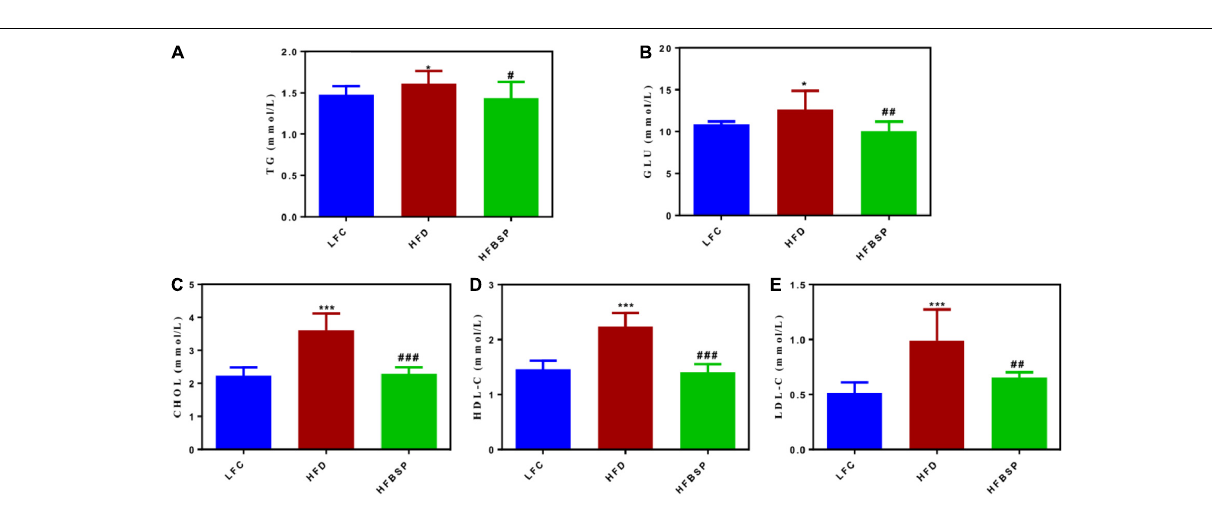
FIGURE 3 | The effect of bamboo shoot powder on the body weight of mice fed a HFD for 7 weeks. Data are means ± SEM, n = 10/group.